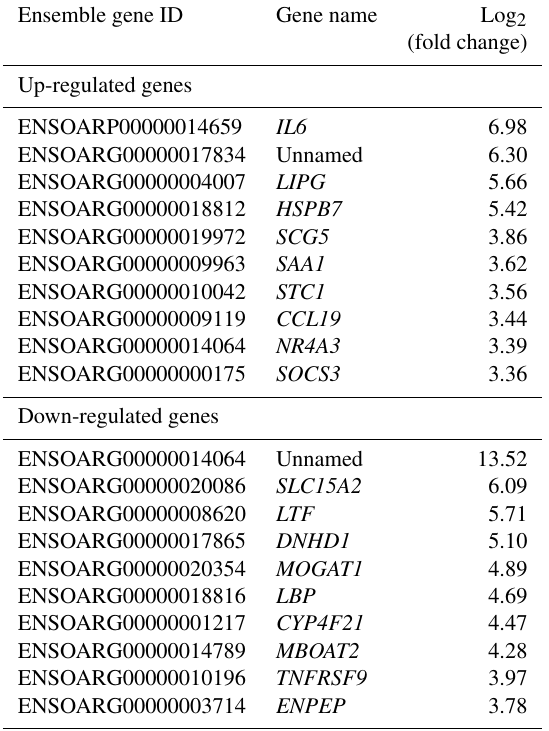
Table 3. Top 10 up- and down-regulated genes in adipose tissue of Zel (thin-tailed) compared to Ghezel (fat-tailed) sheep breeds. Ensemble gene